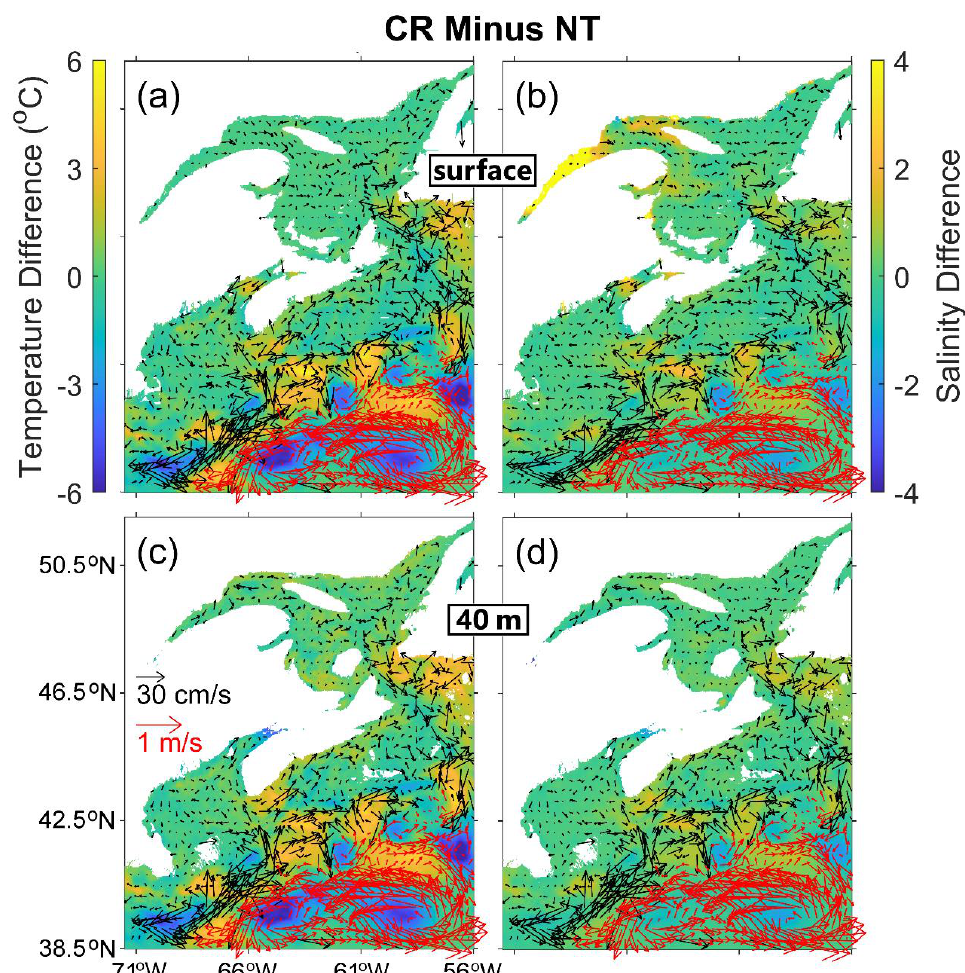
Figure 15. Differences in monthly-mean currents (black and red arrows), temperature ( a , b ), and salinity ( c , d ) simulated by submodel L2 for February 2018 between cases CR and NT at ( a , b ) the surface and ( c , d ) 40 m. For clarity, velocity vectors are plotted at every 12th model grid point. Different scales are used for the black and red